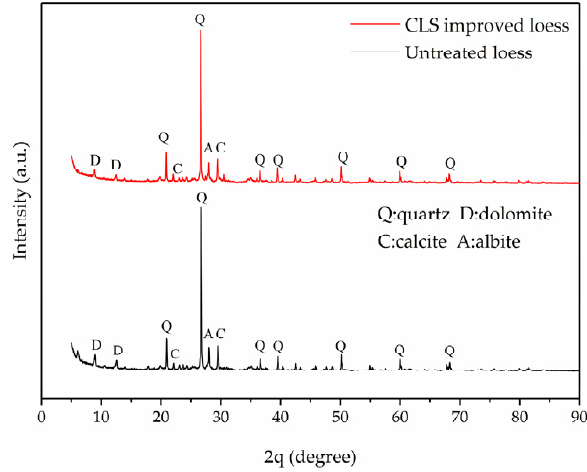
Figure 17. XRD analysis results.